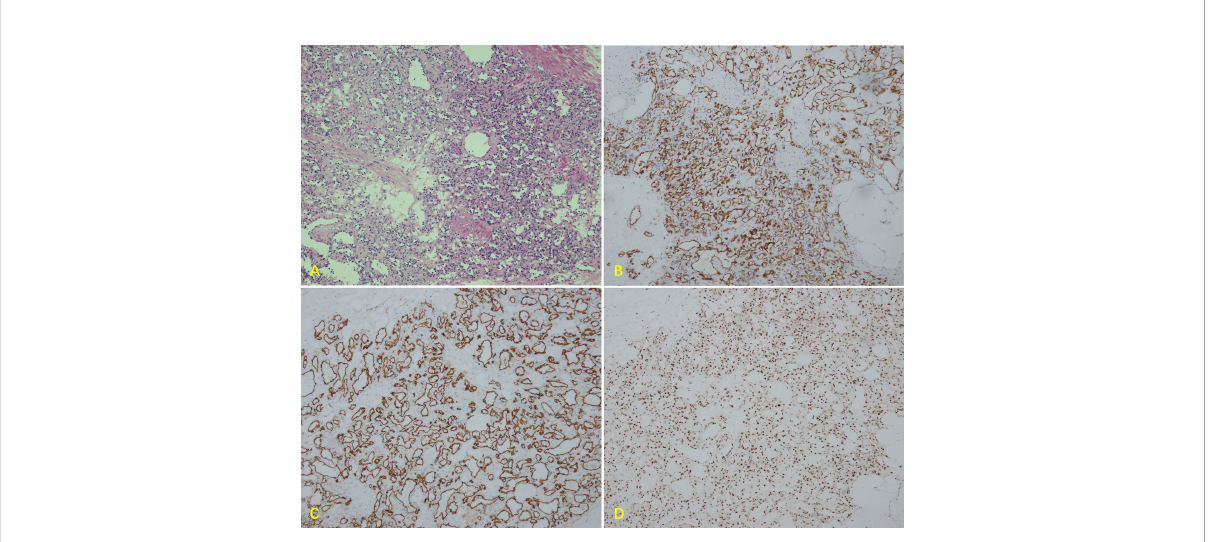
FIGURE 3 Microscopic fi ndings of the renal hilum tumor. (A) Paraf fi n section showing the mass with lobulated capillaries (original magni fi cation x100). Immunohistochemistry showing diffuse strong positivity for (B) CD31, (C) CD34, and (D)